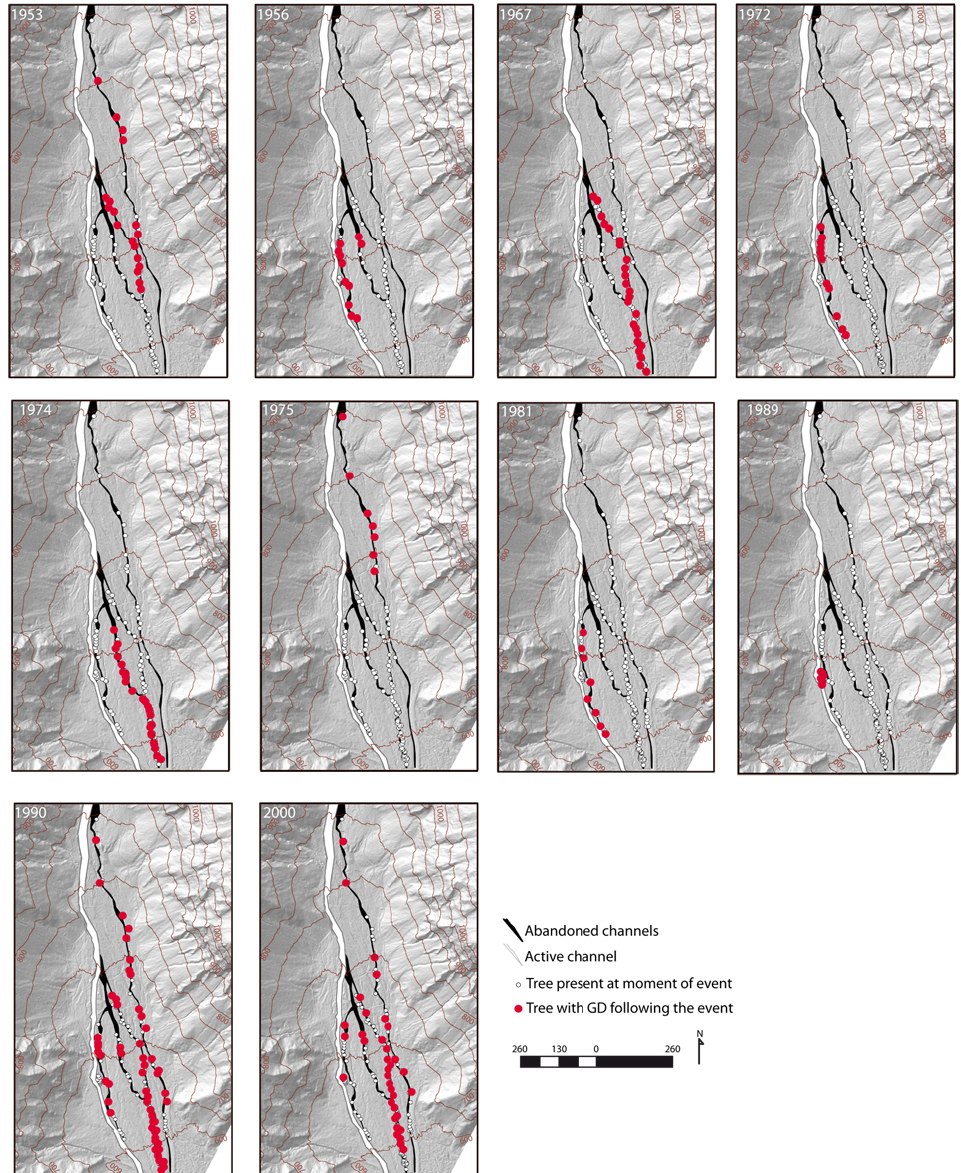
Fig. 7. Location of trees showing growth disturbances (GD) during reconstructed debris-flow events. Maps show all living trees as well as those trees showing an event-response to debris-flow activity in a particular